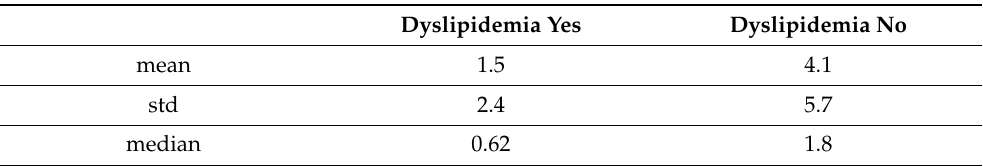
Figure 4. Time course of the concentration levels of cTnT into the plasma of the 27 STEMI patients, with and without dyslipidemia. Each color is associated with the time series of a different patient. Table 2. Mean, std, and median of cTnT concentration over the observation interval, for dyslipidemic and non-dyslipidemic